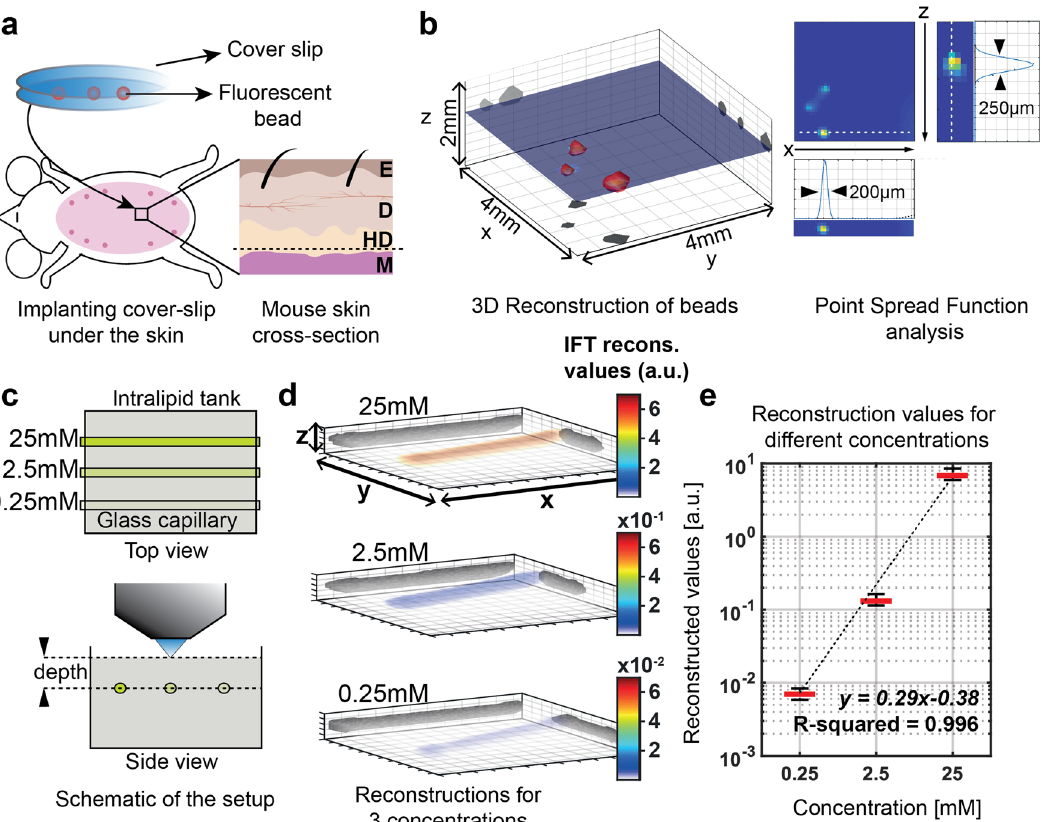
Fig. 2 Characterization of IFT. a Fluorescent beads, sandwiched between cover-slips, were placed under the mouse skin (dashed line) in the hypodermis (HD) under the epidermis ((E) and dermis (D), above the muscle (M). b Spatial resolution analysis based on tomographic reconstruction of these beads. Point-spread function (PSF) indicating lateral and axial resolution. c In vitro control experiment to establish linearity of the reconstruction algorithm. Glass capillaries fi lled with fl uorescein of different concentrations (25, 2.5, and 0.25 µ M) inside an 10% Intralipid tank at 1.3 mm depth were imaged separately by IFT. d Reconstructions in 3D ( x , y , z = 11 × 11 × 2 mm 3 ) for each concentration. Color bar indicates the reconstructed signal value (a.u.). e The imaged concentrations show a linear relationship in their reconstructed IFT signal. For each data point, the central mark indicates the median, the bottom and top edges of the box indicate the 25th and 75th percentiles,